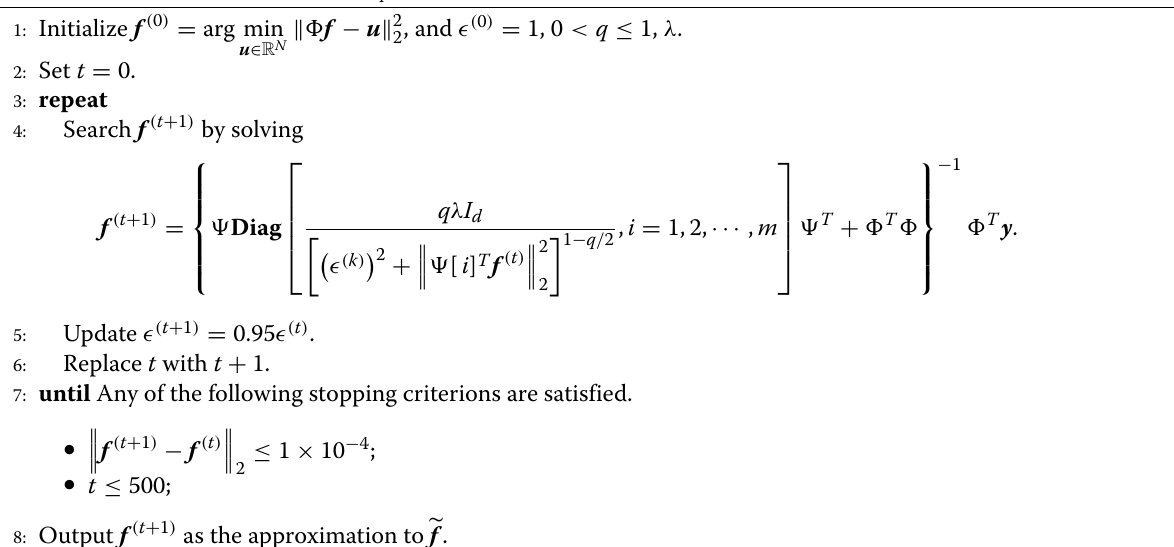
Algorithm 1 IRLS algorithm for (cid:2) 2 /(cid:2) q -analysis problem